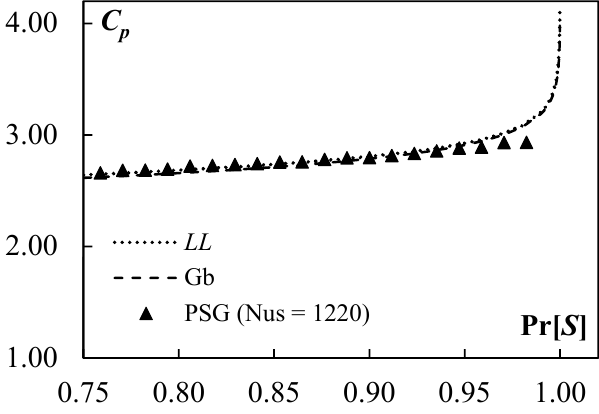
Figure 2. Peak water demand coefficient [ C p ] F versus Pr[ S ].